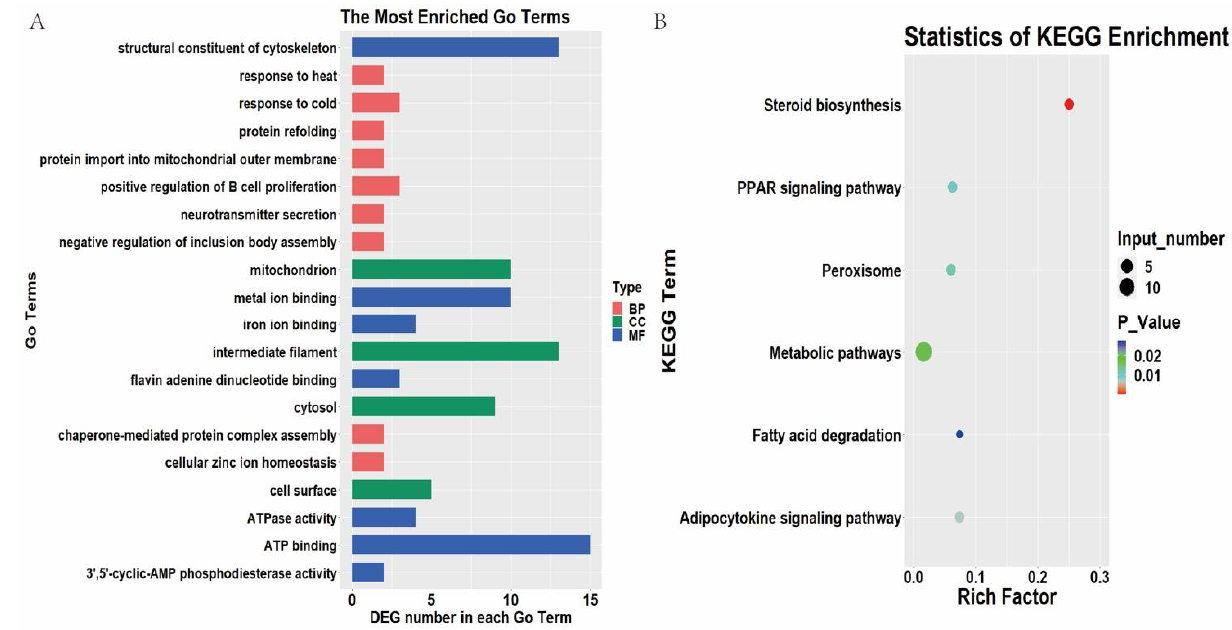
Figure 2. GO and KEGG enrichment of differentially expressed genes (DEGs) between 35 and 12 weeks. ( A ). Top 20 GO terms of DEGs between 35 and 12 weeks. ( B ). Enriched KEGG pathway of DEGs between 35 and 12 weeks.